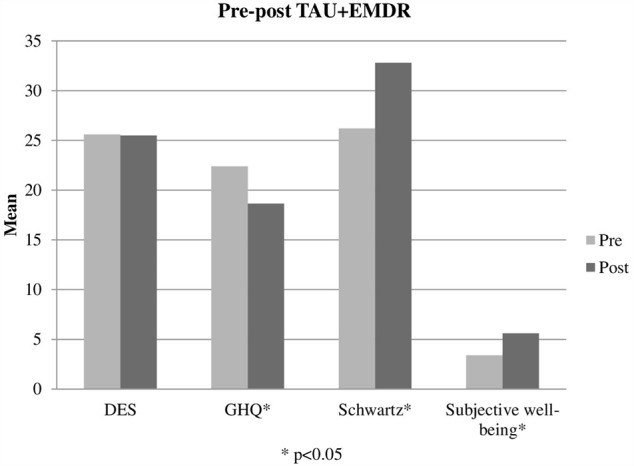
Pre-post TAU+EMDR.